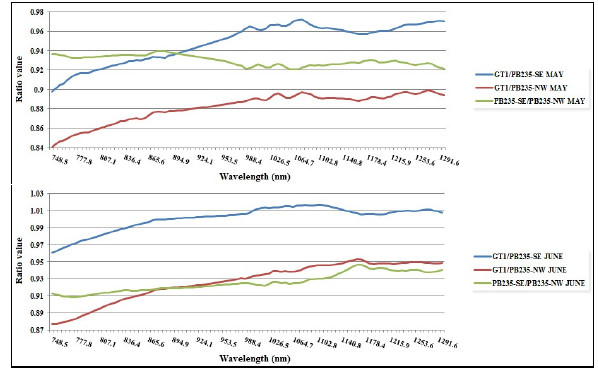
Figure 14. Ratios among spectra of the Rubber trees stands (GT1, PB235-SE and PB235-NW) from 740 to 1,300nm for